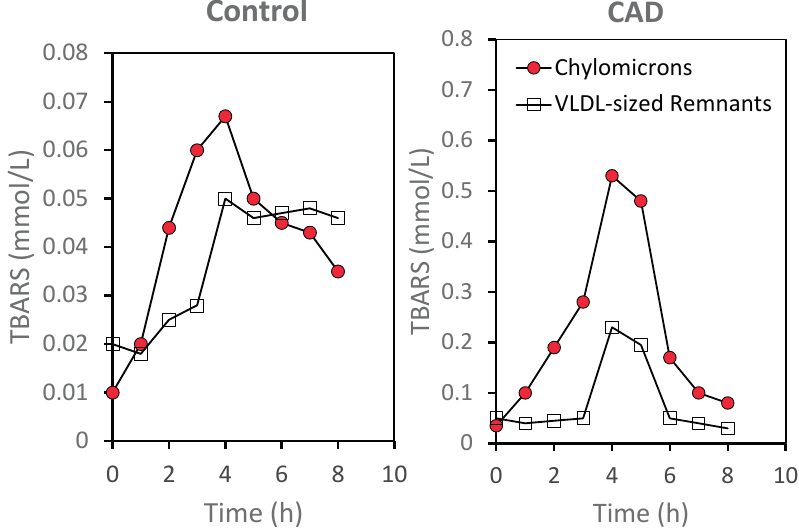
Figure 5. Time-dependent changes in lipid hydroperoxides as assessed by TBARS in lipoprotein fractions isolated by density ultracentrifugation following meal consumption. Note the differences in scale for the y -axis. Closed circles: Chylomicron fraction. Open squares: VLDL-sized remnants (for details on the isolation methods see